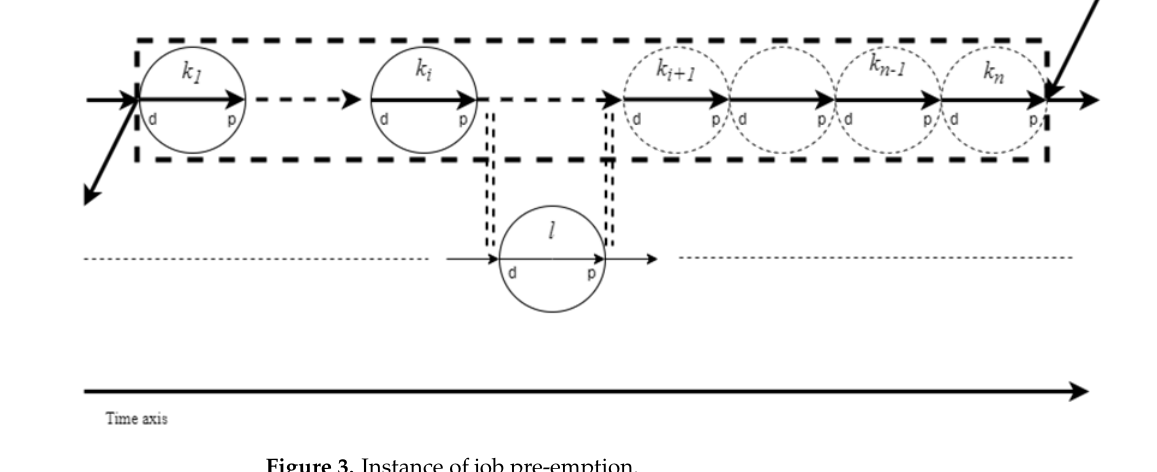
Figure 3. Instance of job pre-emption.